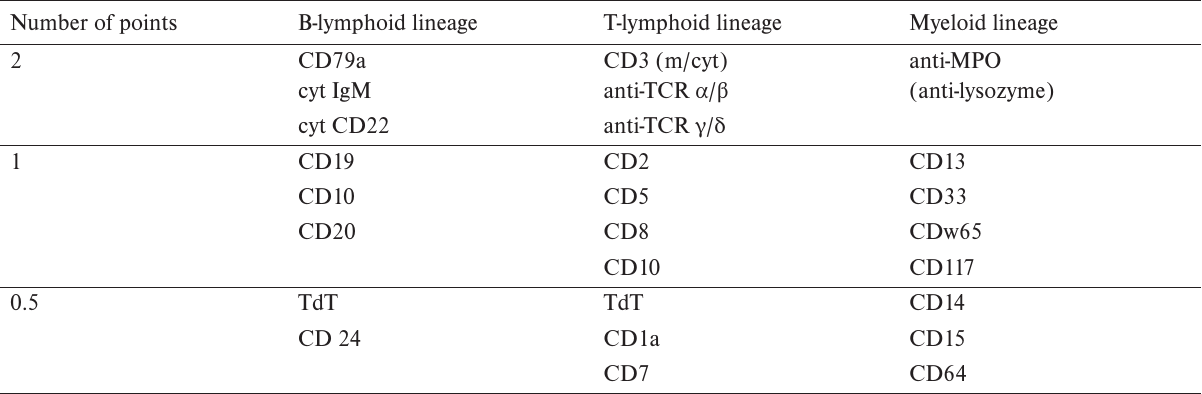
Table 1. Diagnostic criteria for biphenotypic acute leukemia published by the EGIL in 1998 (ref. 10 ).